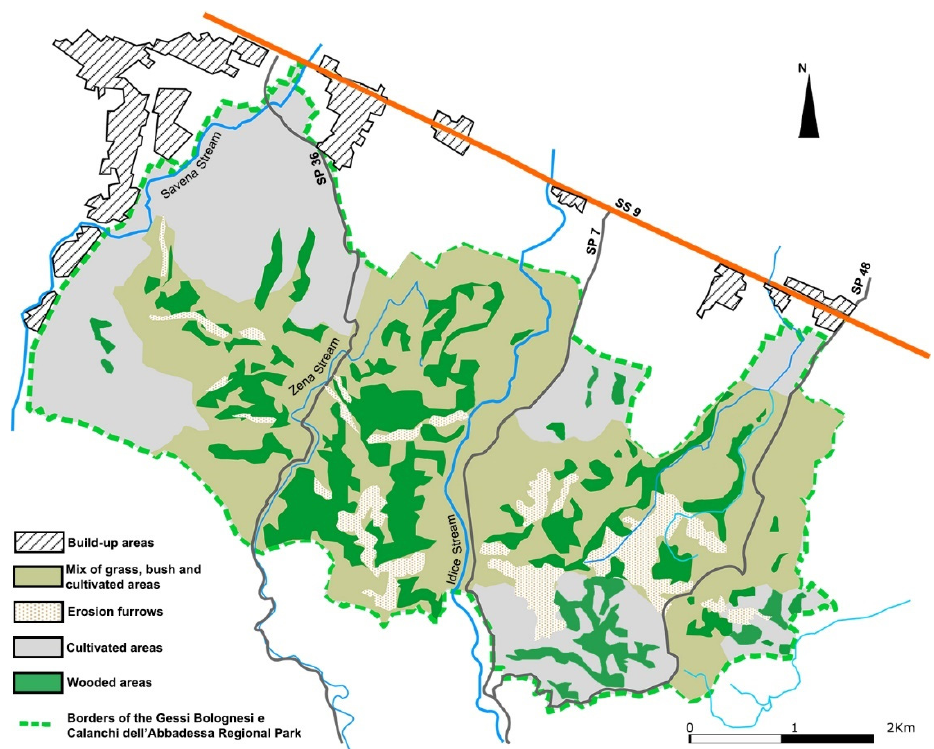
Figure 1. Protected area of Northern Italy where 2645 wild boar ( Sus scrofa ) sera were examined by serological assays to assess influenza A virus circulation between 2007 and 2014.